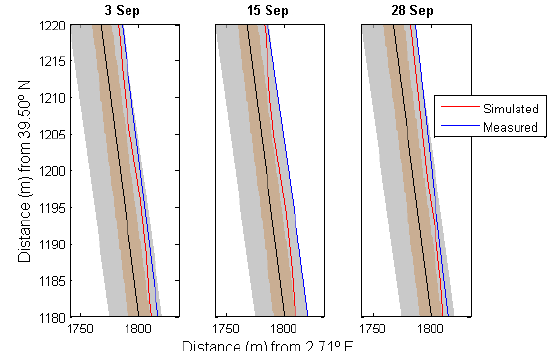
Figure 15. Modelled (red) and observed (blue) shorelines positions in Playa de Palma with mean shoreline position (black line), its stan- dard deviation (grey shadow) and the resolution of the pixels of the cameras (orange